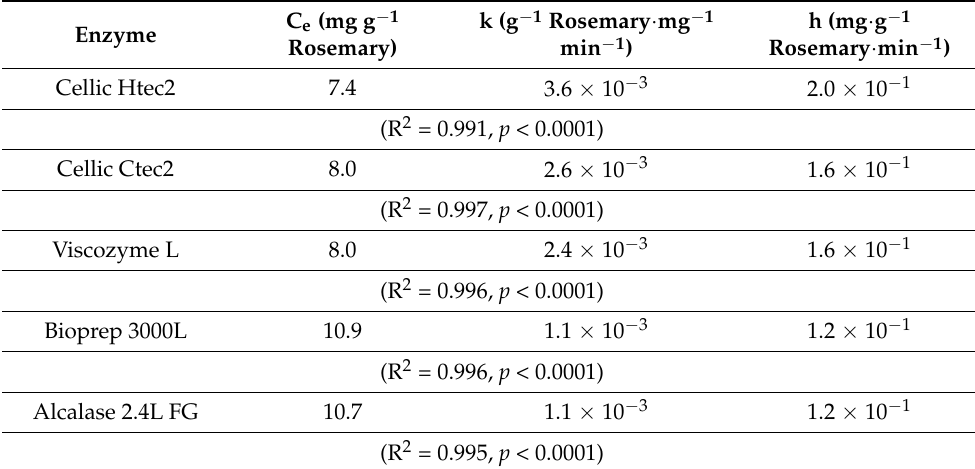
Figure 1. Effect of enzymatic extraction time on TPC. Symbols: ( • ) Alcalase 2.4L FG, ( ( (cid:78) ) Viscozyme L, ( (cid:52) ) Cellic HTec2, ( (cid:72) ) Bioprep 3000L. Dashed lines are the non-linear fitting curves (Equation (2)). Table 3. Kinetic parameters of